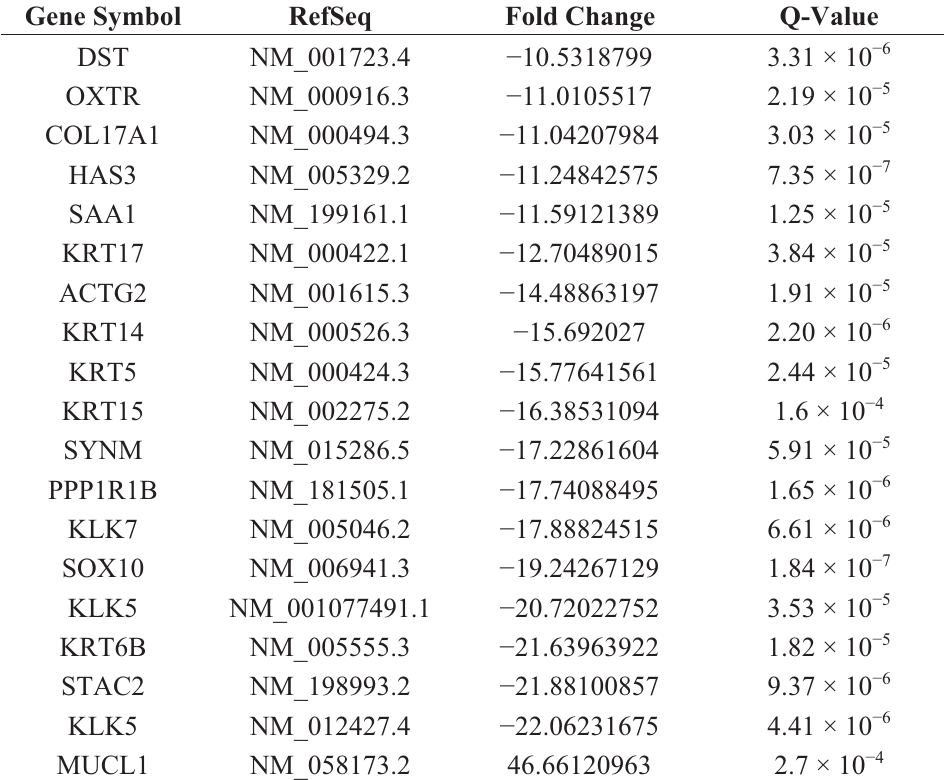
Table 4. List of genes downregulated in the breast cancer group compared with normal breast